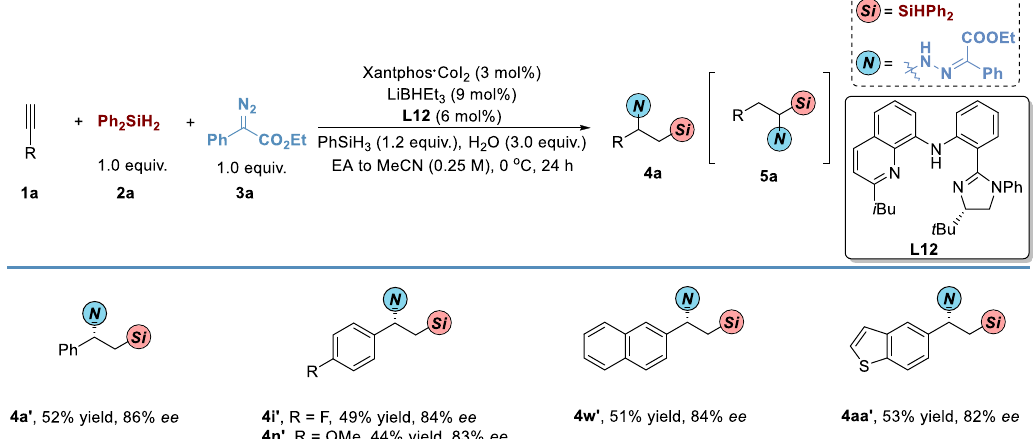
Fig. 5 Substrate Scope of Asymmetric Sequential Hydrosilylation/Hydrohydrazidation of Alkynes via Ligand Relay Catalysis. a Reaction conditions: 1 (0.3 mmol), 2 (1.0 equiv.), 3 (1.0 equiv.), Xantphos (cid:129) CoI 2 (1 mol %), LiBHEt 3 (3 mol %), L12 (2 mol %), PhSiH 3 (1.2 equiv.), and H 2 O (3.0 equiv.) in EA to MeCN (1.2 mL) under nitrogen at 0 o C for 24 h, isolated yield of 4 with complete regioselectivity without additional indications. The details can be found in the Supplementary Information.